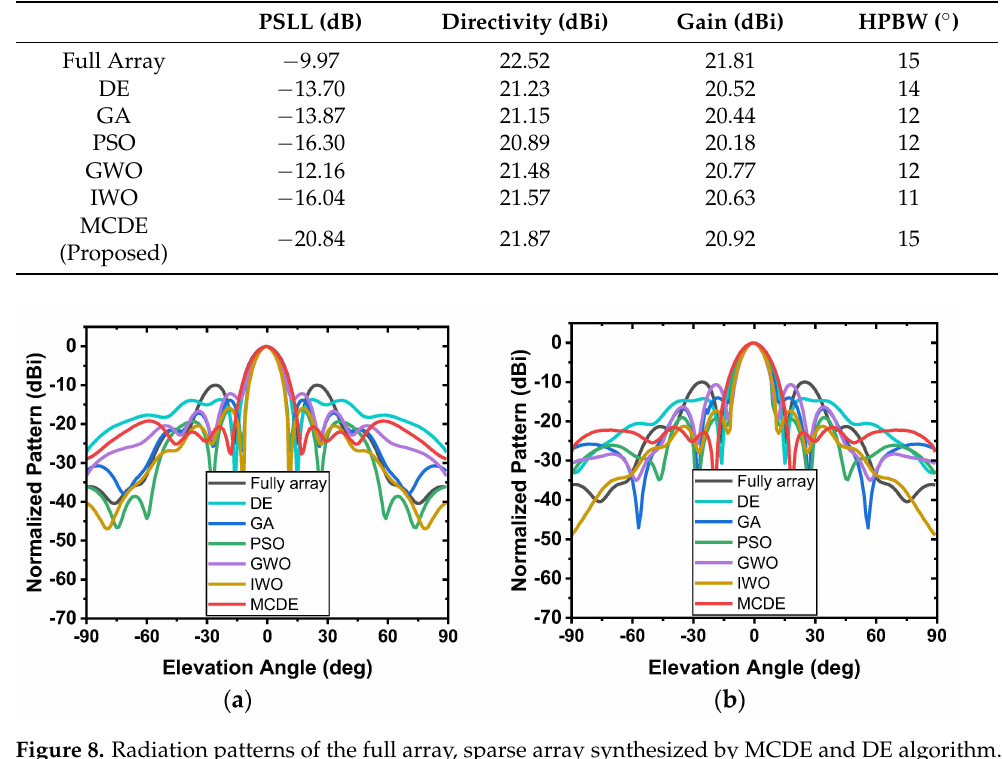
Table 4. The Performances of the Array I.